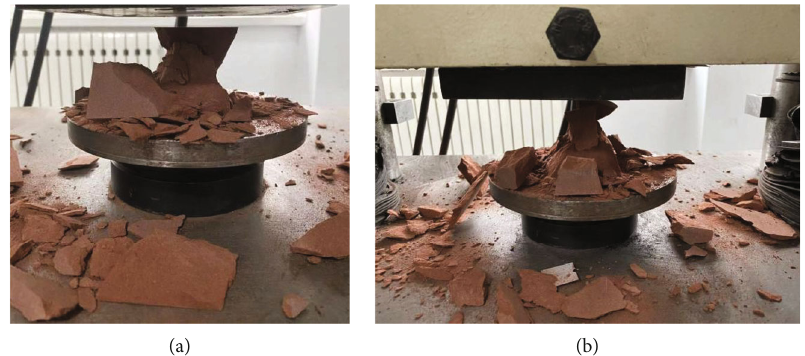
Figure 13: (a) Uniaxial compression failure state. (b) Cyclical loading fi nal failure